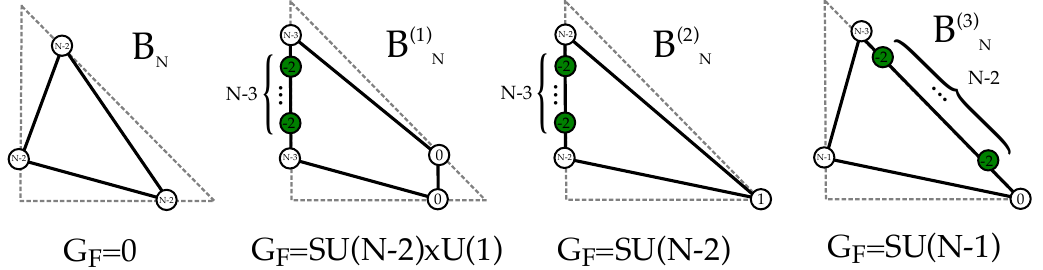
Figure 4 . The non-Lagrangian theories determined in [31] obtained from T N after decoupling all hypermultiplets, as well as their (cid:13)avor symmetries G F